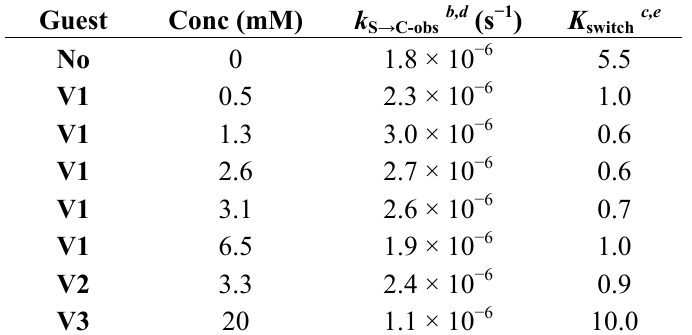
Table 4. Calculated rate constants ( k switching of S to C in solutions with different concentrations of viologen guests V1 − V3 .